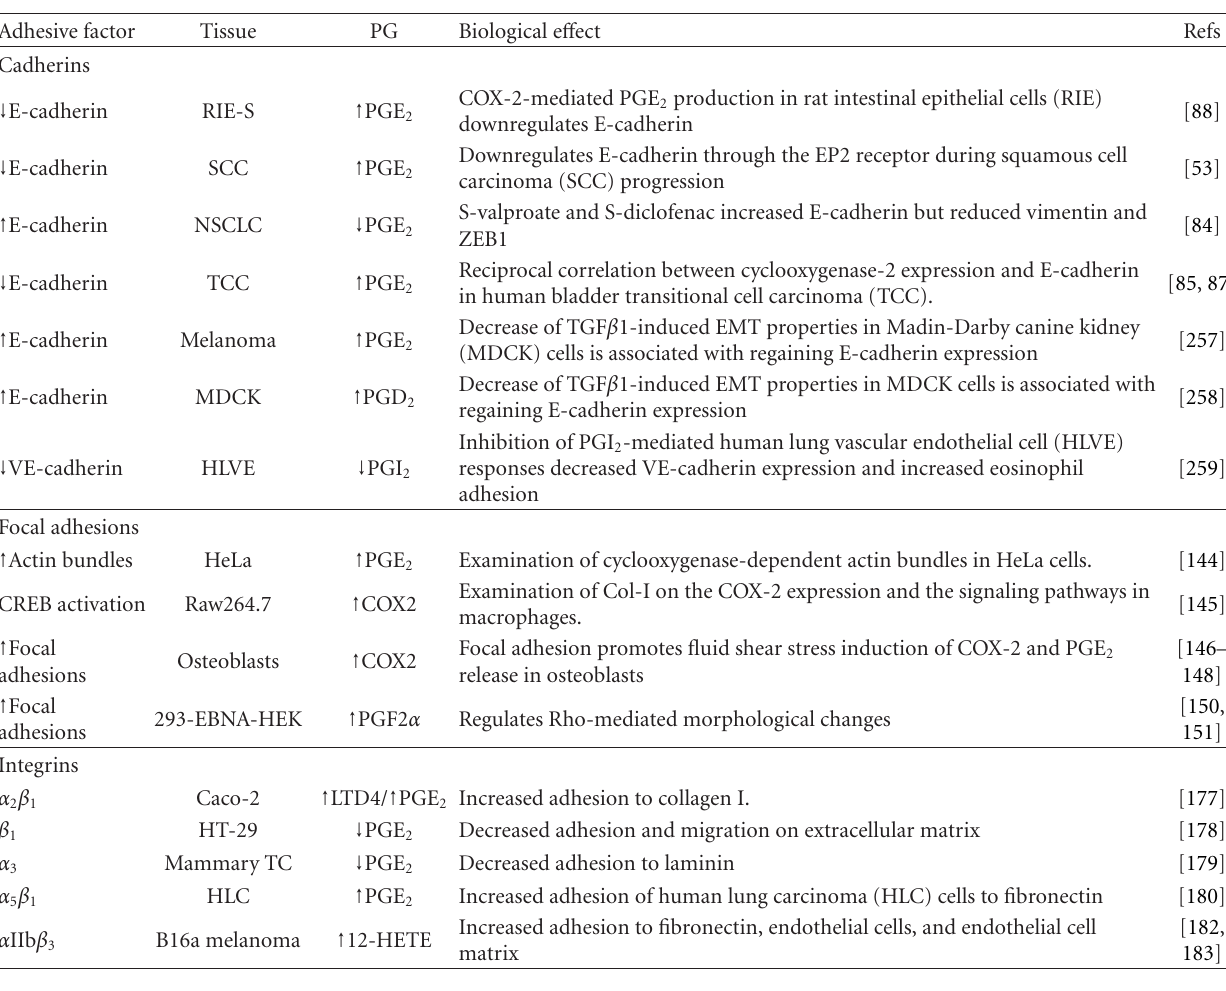
Table 1: Prostaglandins in cancer cell adhesion, migration, and invasion summary